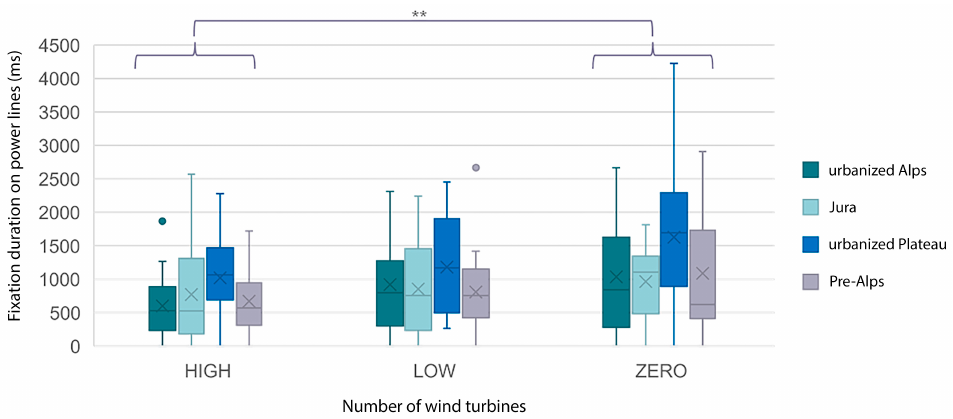
Figure 9. Fixation time during free perception in the AOI of power lines depending on the landscape and the number of wind